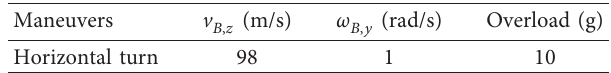
Table 10: Parameters of maneuver flight.